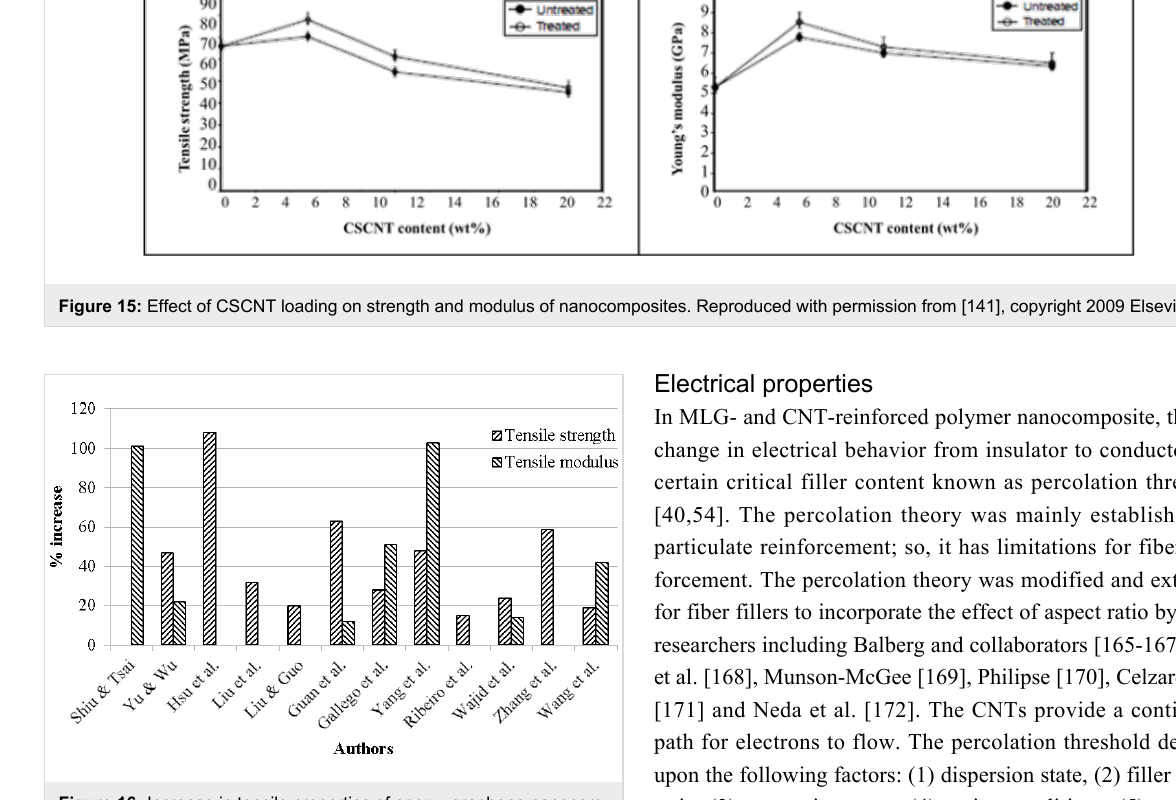
strength and modulus, respectively [147]. Qi et al.